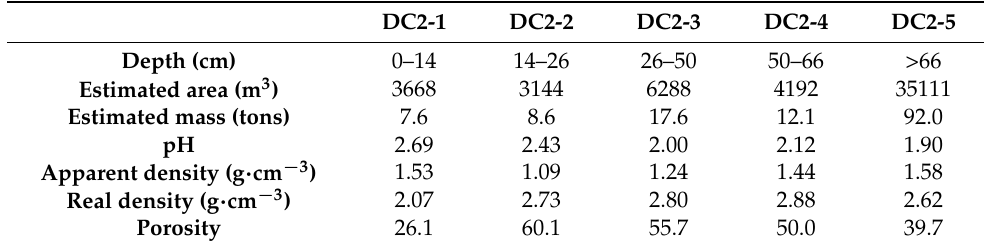
Table 2. General characteristics for the tailings